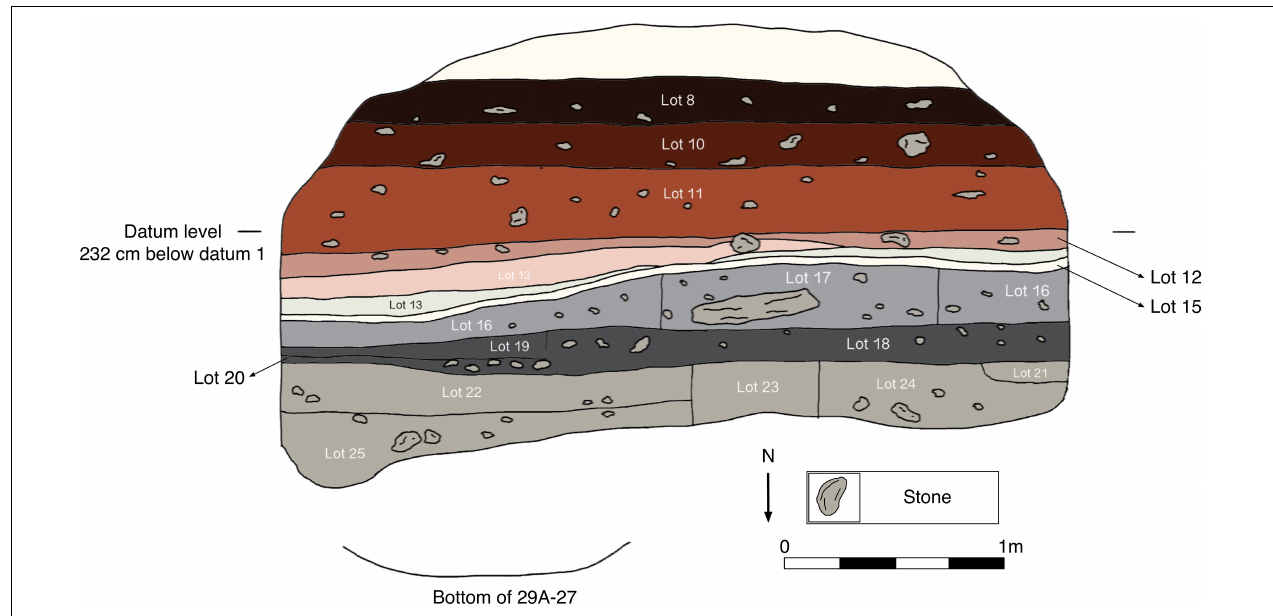
FIGURE 6 | Profile drawing of Operation 29A (the chultun next to the Fidelia complex). Lot number 15 corresponds with Floor #1 discussed in the